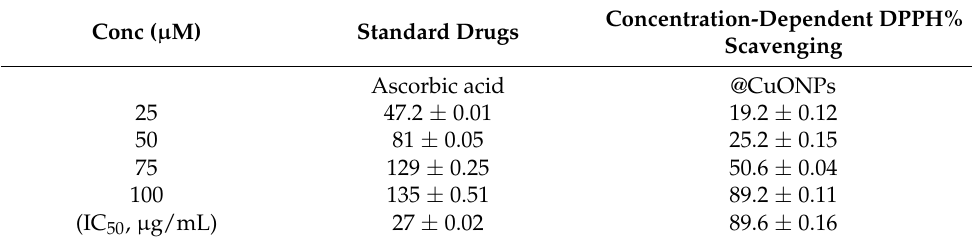
Table 3. Antioxidant activity against DPPH.